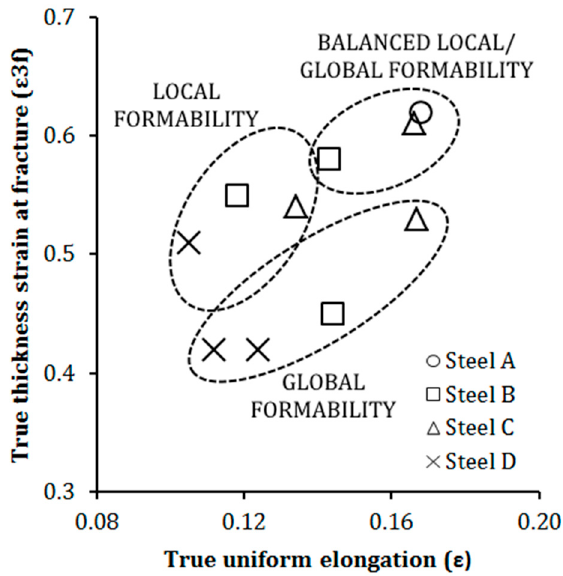
Figure 11. Evaluation of formability properties of the investigated steels.